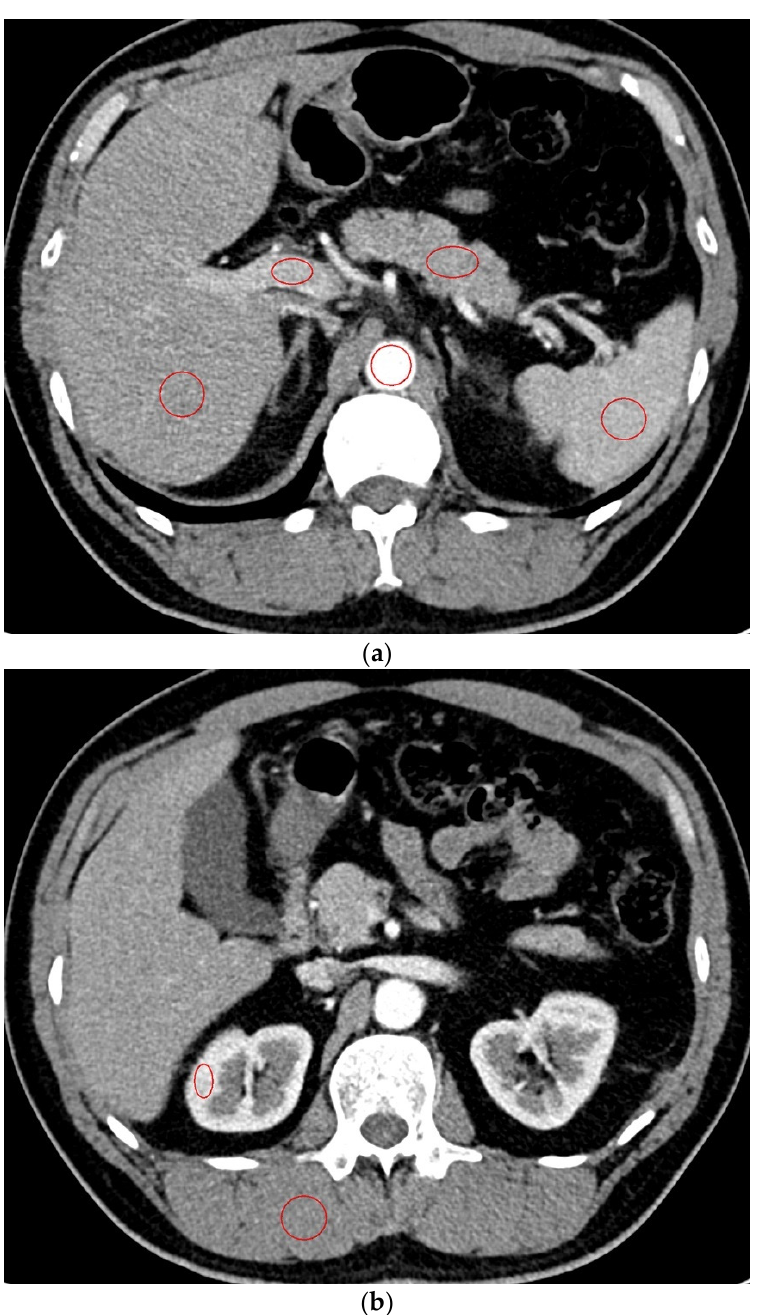
Figure 1. Quantitative analysis of the CT images A radiologist draws multiple regions of interest in the liver, pancreas, spleen, portal vein, and aorta ( a ) and in the kidney and paraspinal muscle ( b